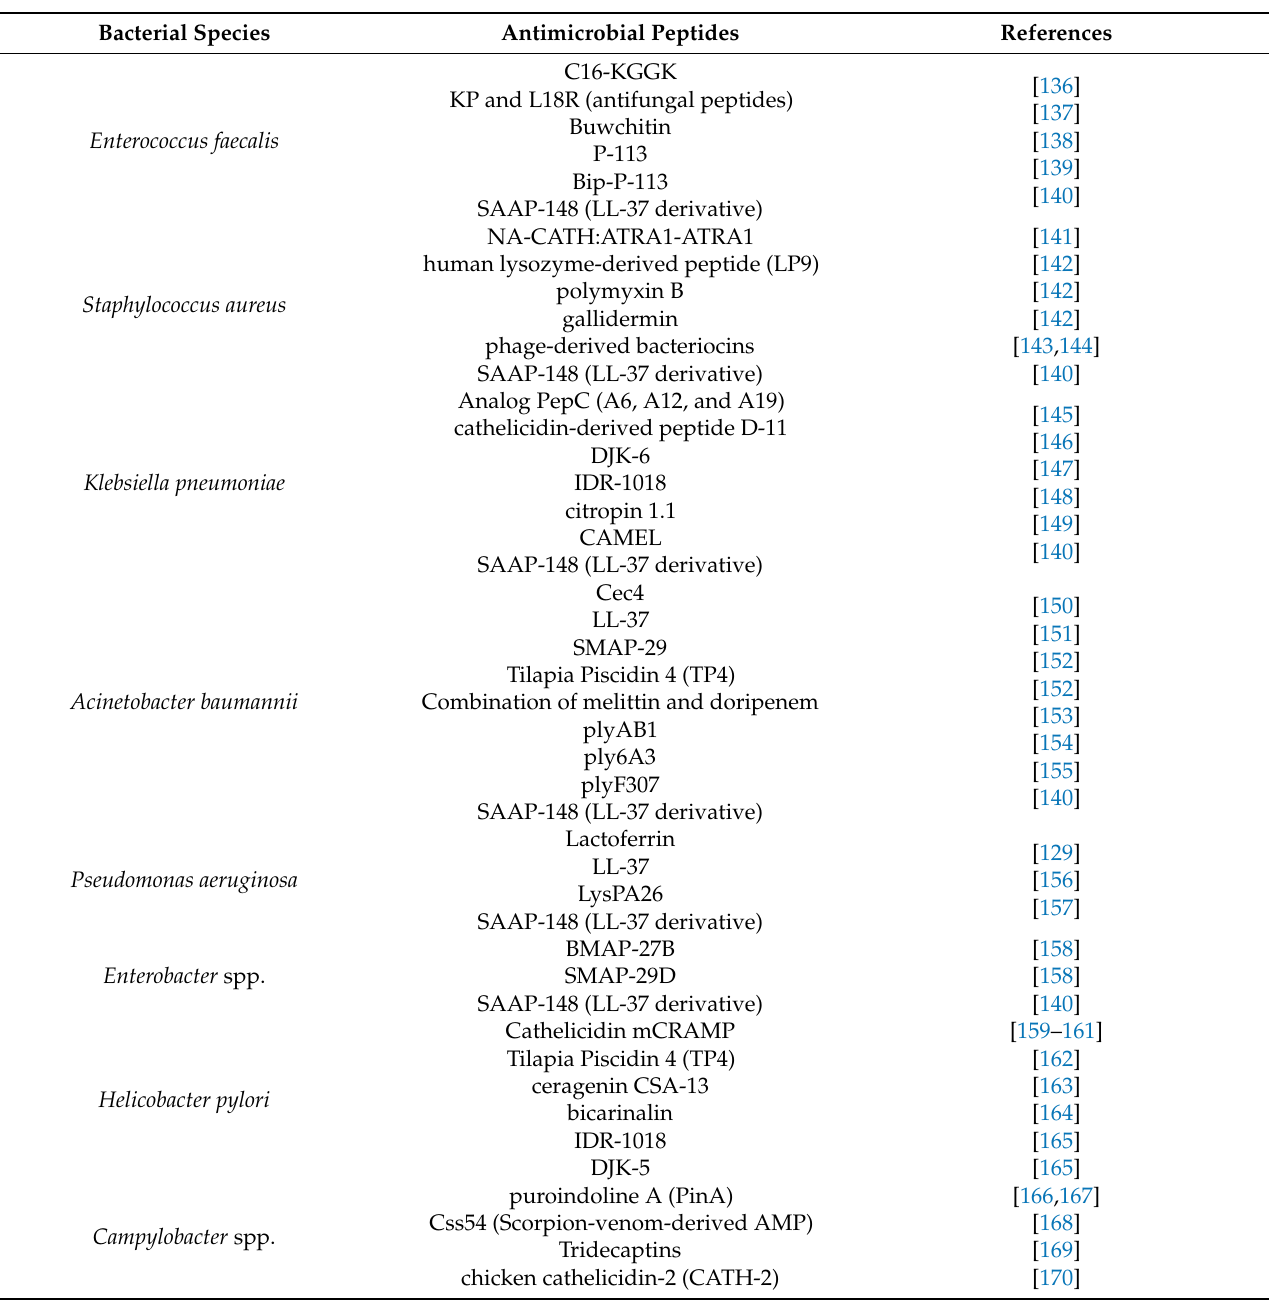
Table 2. Antimicrobial peptides effective against bacterial biofilm-producing Gram-positive and Gram-negative